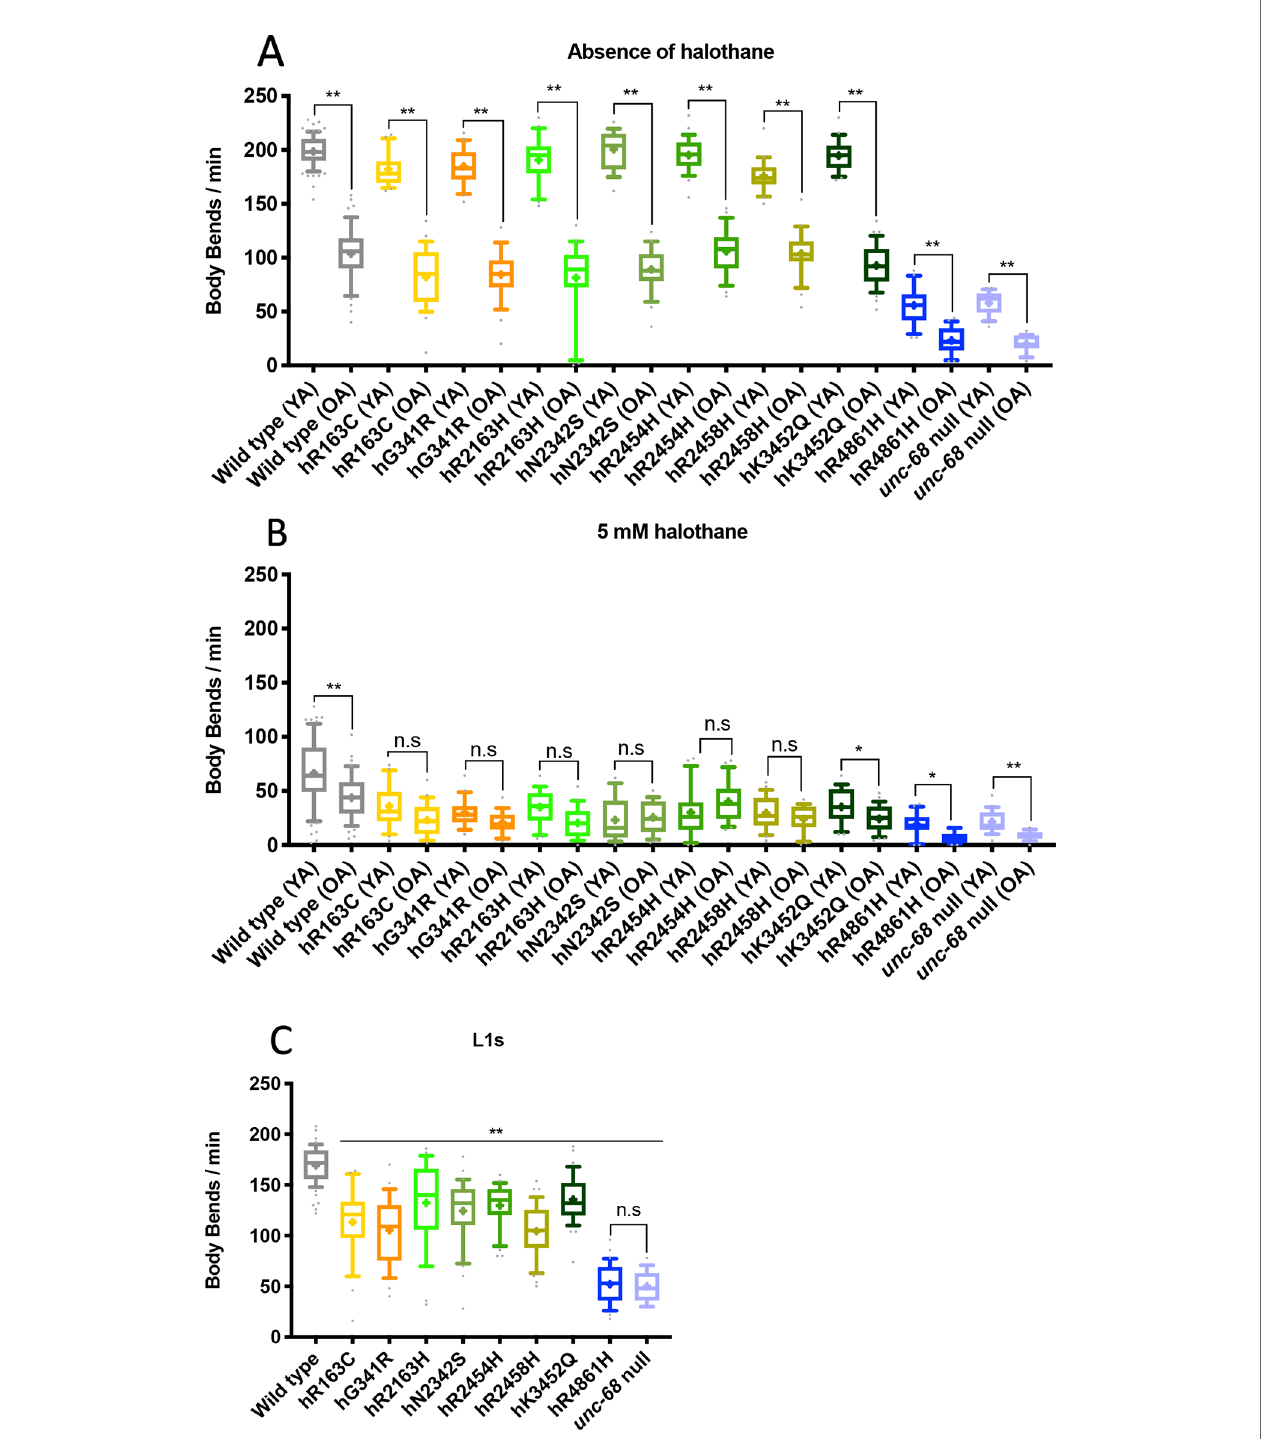
FIGURE 2 | Locomotion is differentially affected across the lifespan by ryanodine receptor (RyR) variants. Thrashing rate in S medium, in body bends per minute, for RyR variant strains, labelled by the human variant they correspond to, along with the N2 wild type and the CB540 unc-68(e540 ) null mutant. Comparisons are between young adult (YA) and old adult (OA) in the absence (A) and presence (B) of 5 mM halothane or between strains as L1s in the absence of halothane (C) . 25 individuals were examined per strain. Boxes indicate the median and interquartile range, with whiskers to the 10 – 90 percentile, outliers as dots, and + to indicate the mean. Signi fi cance is between ages of each variant strain (A, B) or to the wild type (C) . * P < 0.05, ** P < 0.005, n.s, not signi fi cant [one-way ANOVA, with Sidak ’ s multiple comparison test (A , B) , and Tukey ’ s multiple comparison test (C)